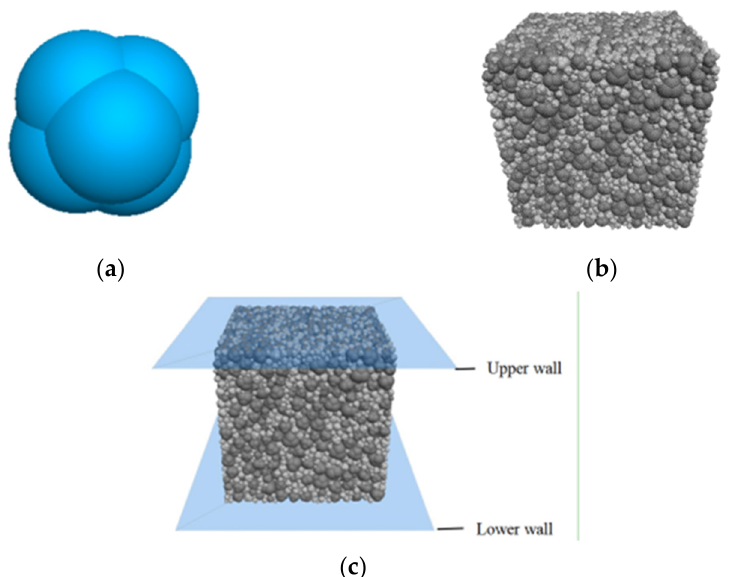
Figure 2. ( a ) Aggregate model ( b ) DEM model of pervious concrete ( c ) Axial loading diagram.